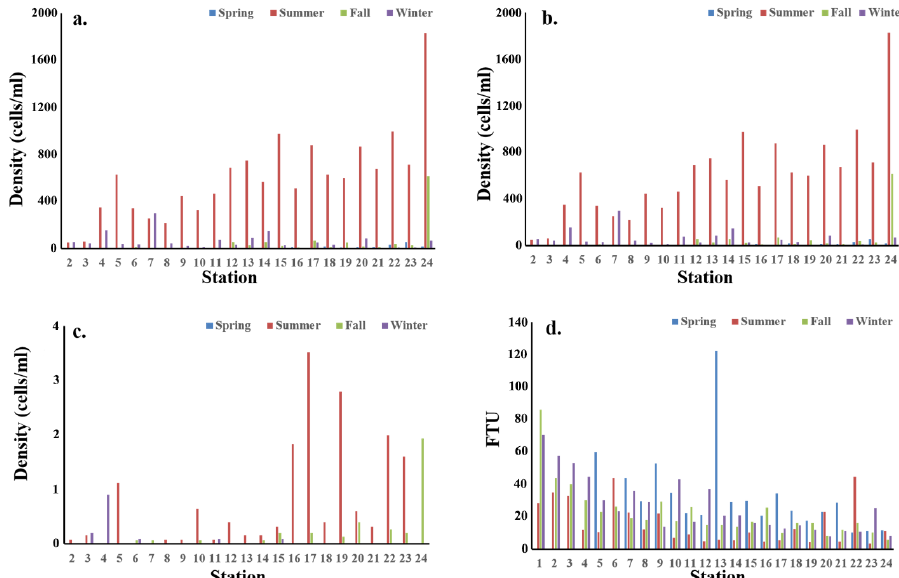
Figure 5. Horizontal distribution of surface ( a ) phytoplankton (cells/mL), ( b ) diatoms (cells/mL), ( c ) dinoflagellate (cells/mL), and ( d ) turbidity (FTU) during the study period. Blue columns corre- spond to spring, red columns correspond to summer, green columns correspond to fall, and purple columns correspond to